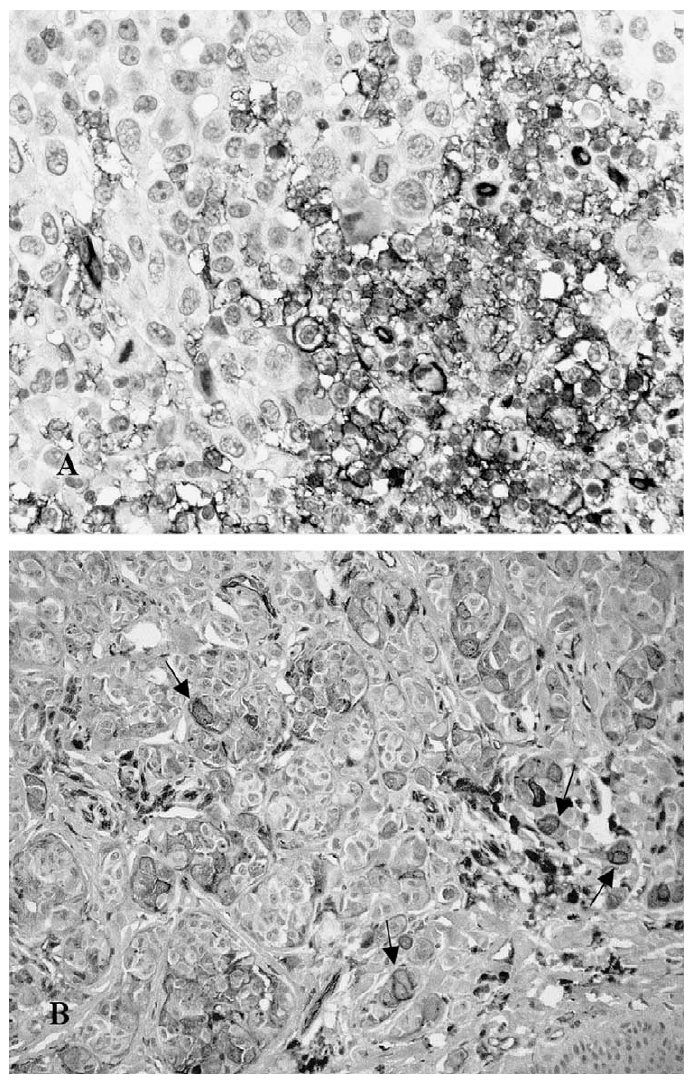
Fig. 2. CD31 (A) and CD34 (B) immunoreactivity in Clark’s level IV melanoma: strong and complete immunostaining of cytoplasmic membranes in tumoral cells ( arrows ) (Original magnification ×